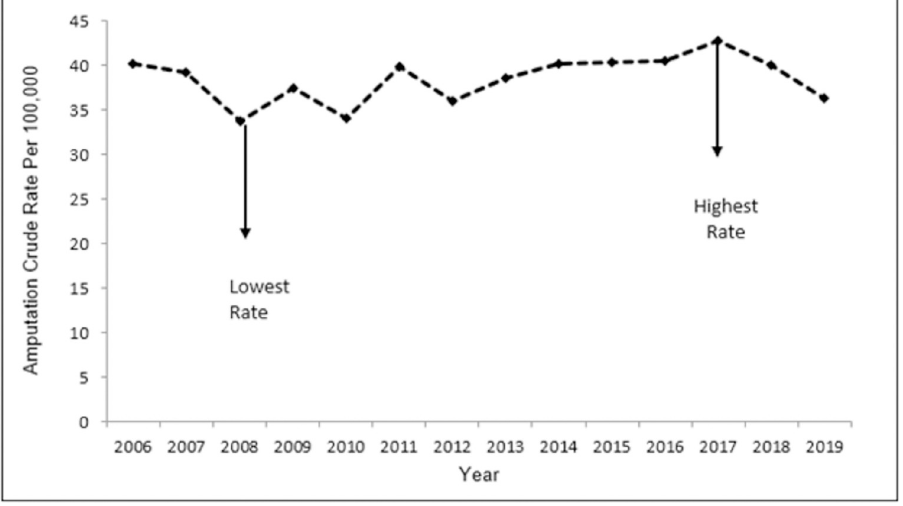
Fig 1. Plot depicting the lowest and the highest overall amputation LA rates in Saskatchewan, 2006–2019.